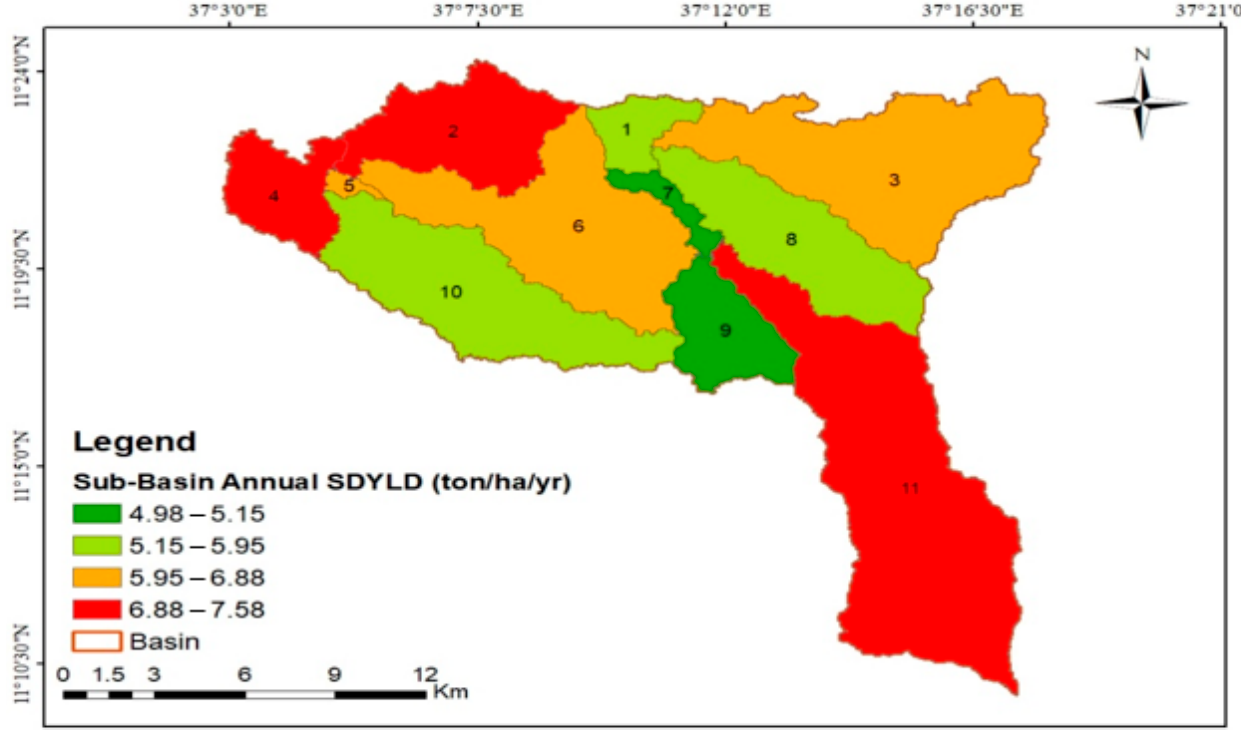
Figure 9. Geographical distribution of sediment yield in the Koga catchment. Table 8. The areal distribution of sediment yield in each sub-basin of the Koga